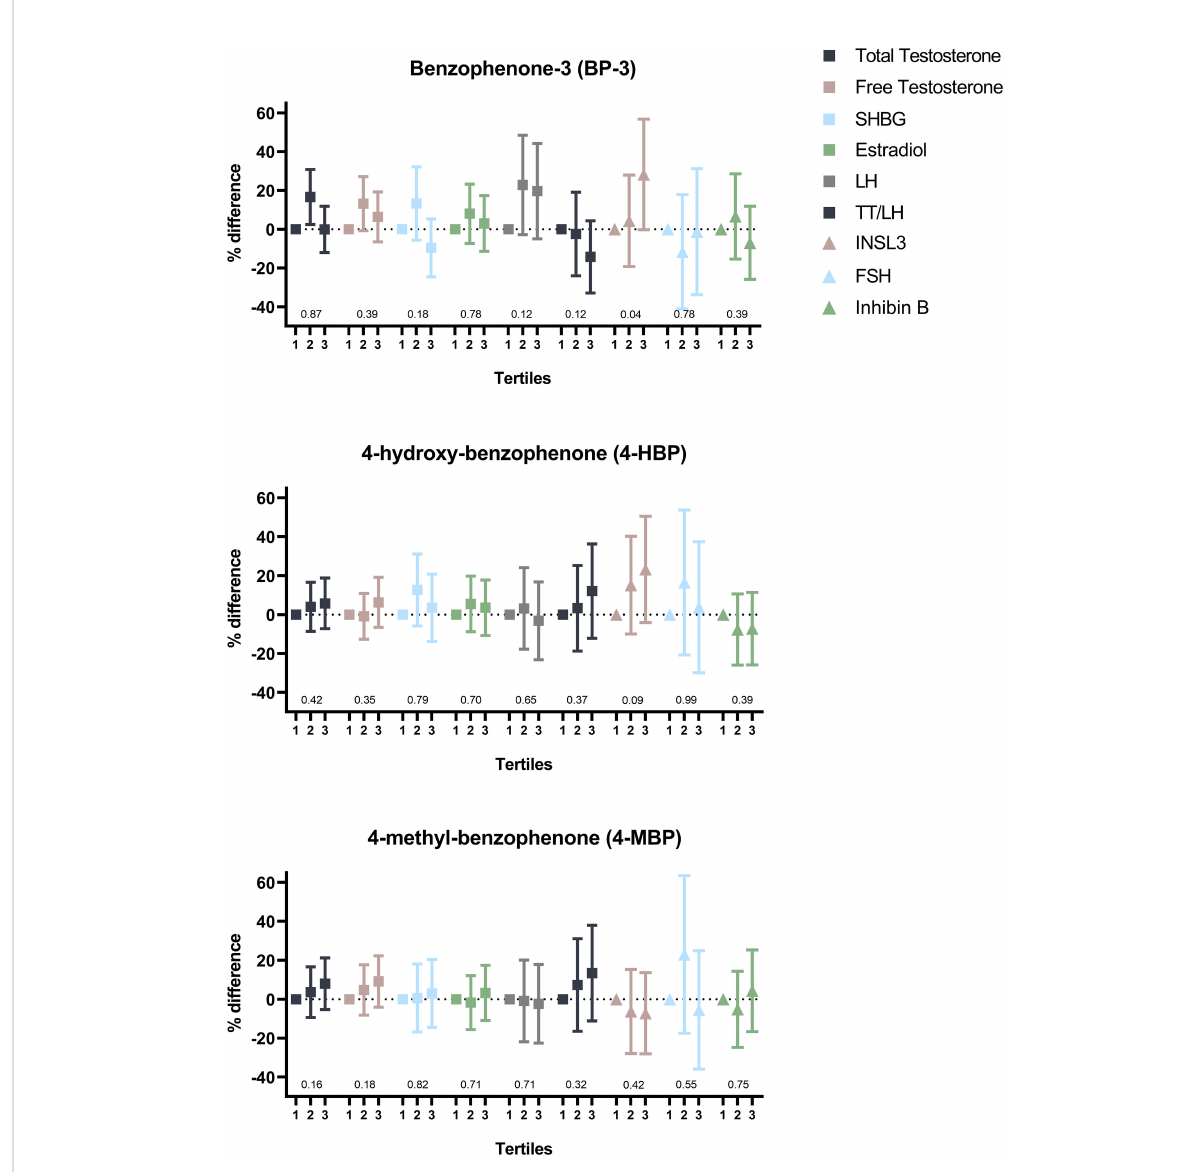
FIGURE 4 Percentage difference in levels of serum hormone concentrations according to tertiles of prenatal benzophenone exposure level adjusted for confounders. P-values indicate trend across categories. SHBG, sex hormone-binding globulin; LH, luteinizing hormone; TT/LH, total testosterone/Luteinizing hormone ratio; INSL3, Insulin-like factor 3; FSH, follicle stimulating